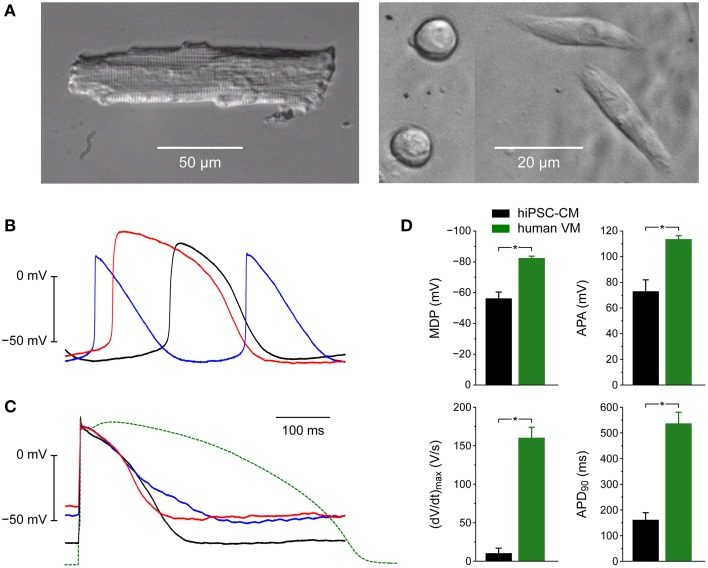
Morphological and electrophysiological phenotype of human induced pluripotent stem cell derived cardiomyocytes (hiPSC-CMs) and native human ventricular myocytes (VMs). (A) Phase-contrast micrographs of a typical human VM (left) and four hiPSC-CMs (right). Differently shaped hiPSC-CMs were present at close distance in the same microscope field. (B) Action potentials of three different spontaneously active hiPSC-CMs. (C) Action potentials of three different intrinsically quiescent hiPSC-CMs upon 1 Hz stimulation (solid lines) and a typical action potential of a single human VM isolated from a failing heart upon 1 Hz stimulation (dashed line). (D) Maximum diastolic potential (MDP), maximum upstroke velocity [(dV/dt)max], action potential amplitude (APA) and action potential duration at 90% repolarization (APD90) of 9 hiPSC-CMs (left bars) and 9 human VMs (right bars), all stimulated at 1 Hz. Human VMs were isolated from explanted hearts of male patients in end-stage heart failure (Verkerk et al., 2005), *P < 0.05.